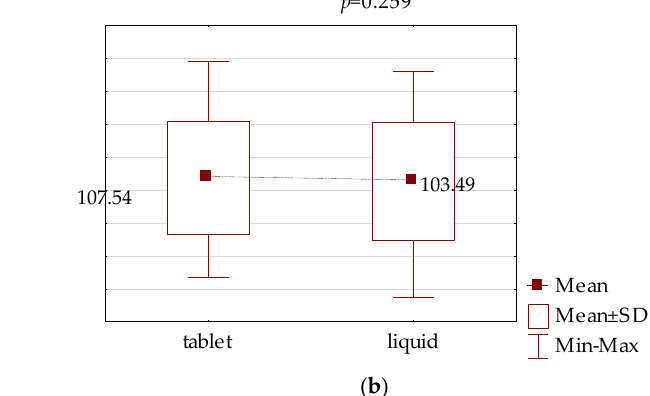
Figure 5. Comparison of LDL-C serum concentration between LT4 therapy in tablet and liquid form in an equivalent dose in: ( a ) primary hypothyroidism and ( b ) central hypothyroidism.